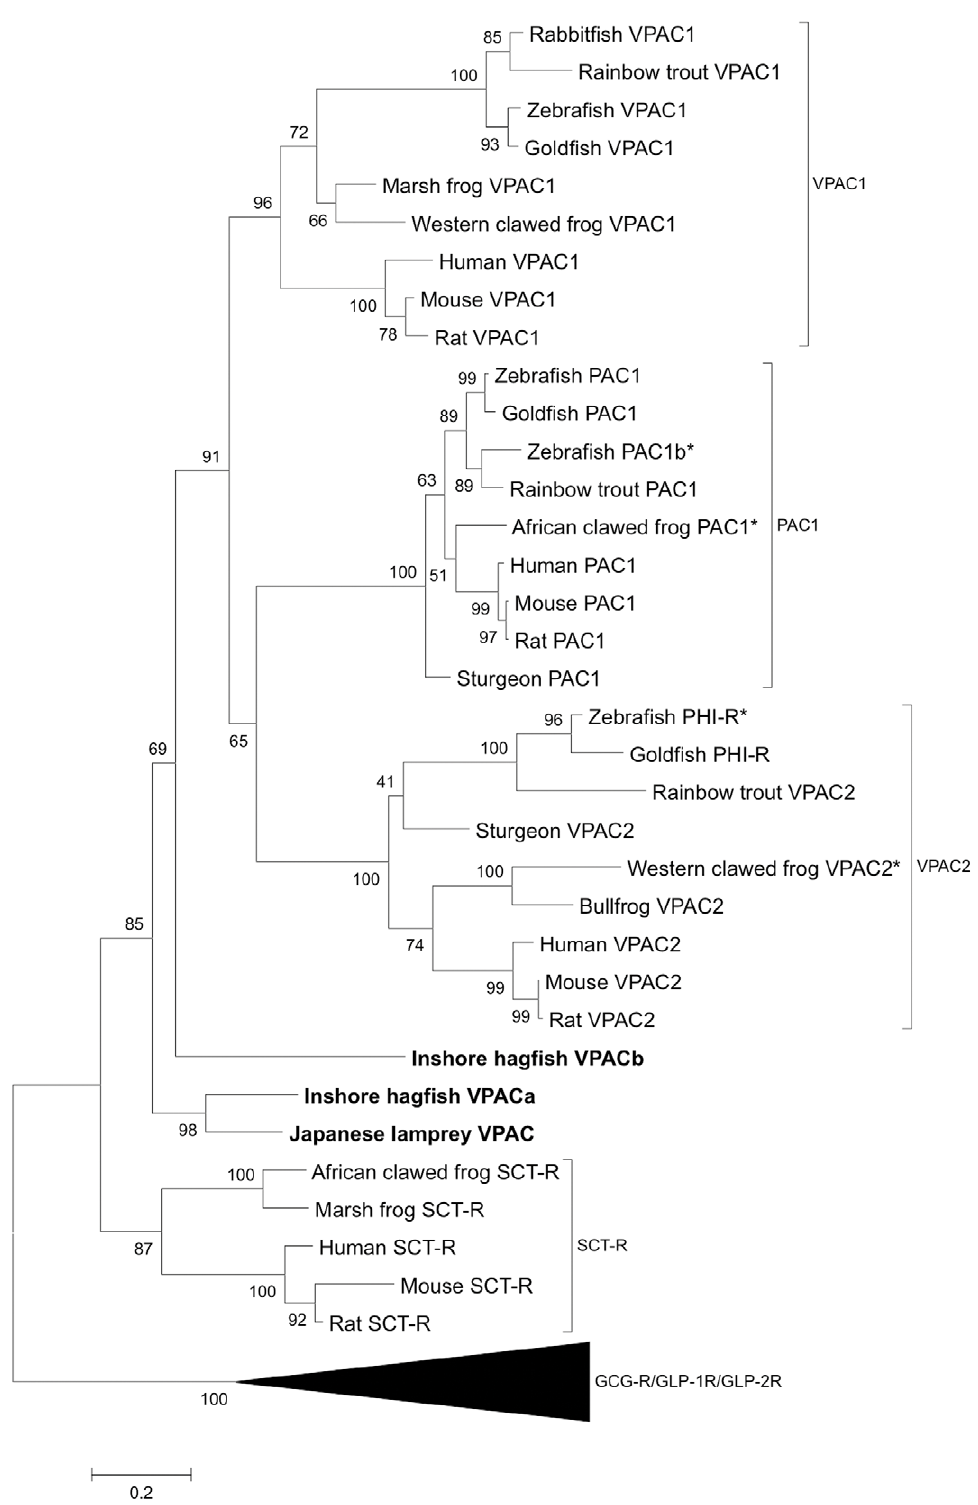
Figure 3. Phylogenetic analysis of vertebrate VIP/PACAP receptors (VPAC 1 , VPAC 2 and PAC 1 ). The tree was constructed based on the PAM Matrix (Dayhoff) model by Maximum-Likelihood method, MEGA 5.0 software. The monophyletic groups are indicated on the right. Cloned receptor sequences from this study are boldfaced. Predicted sequences from the Ensembl genome database are denoted by ‘‘*’’. The numbers above each branch indicate the percentage of bootstrap replications in which that branch was found based on 500 replications. Glucagon, GLP-1, GLP-2 and GIP receptor sequences were used as the outgroup.